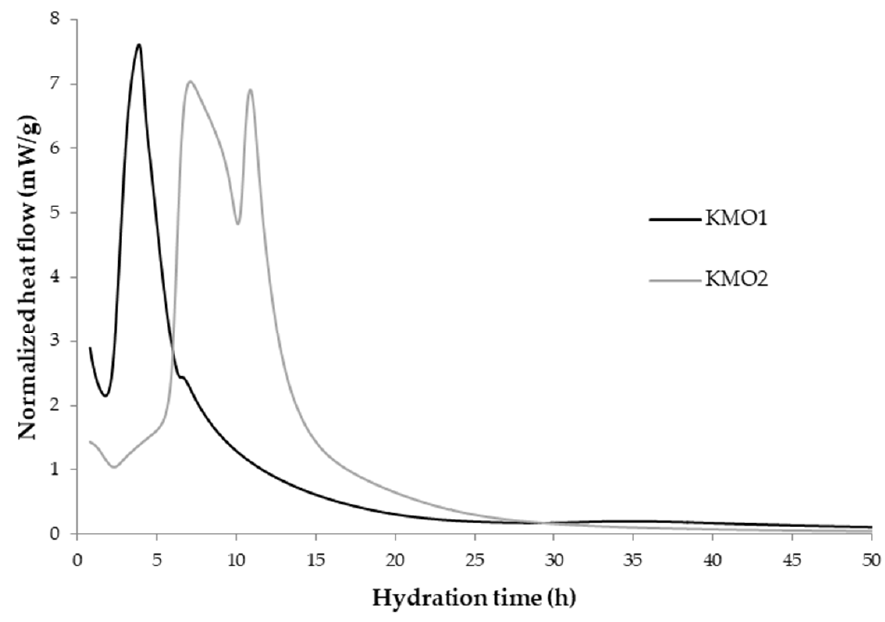
Figure 5. Hydration heat flow of the KMO